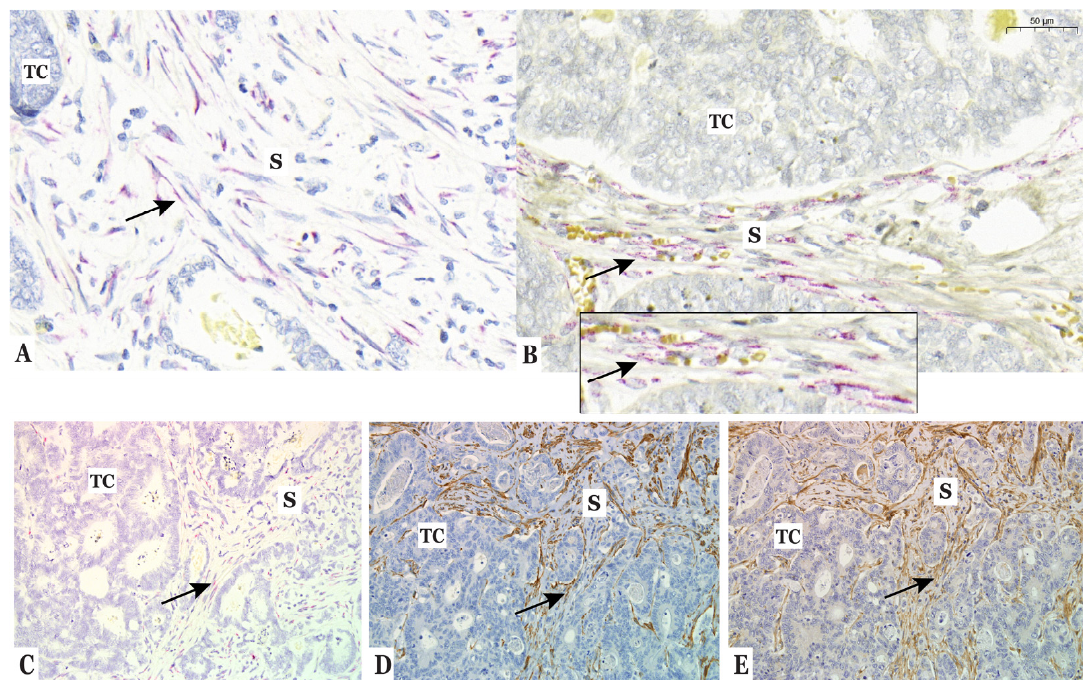
Figure 1. Immunohistochemical staining showing COL IV expression (brown) in stroma (arrow, S) of CLM. ( A ) Magnification ×20 and ( B ) ×40. Abbreviations: TC = tumor cells, S = stroma.